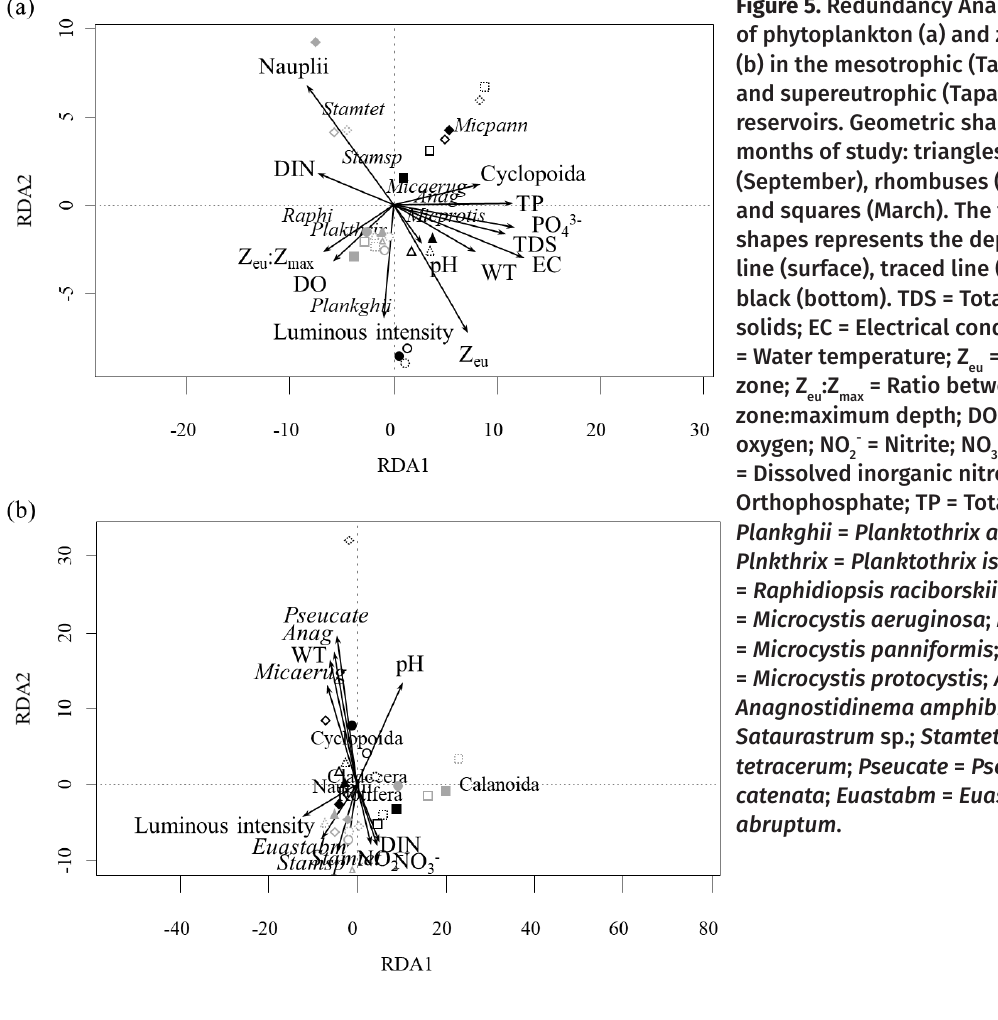
Figure 5. Redundancy Analysis (RDA) of phytoplankton (a) and zooplankton (b) in the mesotrophic (Tabocas, grey) and supereutrophic (Tapacurá, black) reservoirs. Geometric shapes represent months of study: triangles (July), circles (September), rhombuses (January) and squares (March). The filling of the shapes represents the depths: solid ) and all line (surface), traced line (Z eu black (bottom). TDS = Total dissolved solids; EC = Electrical conductivity; WT = Water temperature; Z = Euphotic eu zone; Z :Z = Ratio between euphotic eu max zone:maximum depth; DO = Dissolved oxygen; NO 2- = Nitrite; NO 3- = Nitrate; DIN = Dissolved inorganic nitrogen; PO 43- = Orthophosphate; TP = Total phosphorus; Plankghii = Planktothrix agardhii ; Plnkthrix = Planktothrix isothrix ; Raphi = Raphidiopsis raciborskii ; Micaerug = Microcystis aeruginosa ; Micpann = Microcystis panniformis ; Micprotis = Microcystis protocystis ; Anag = Anagnostidinema amphibium ; Stamsp = Sataurastrum sp.; Stamtet = Staurastrum tetracerum ; Pseucate = Pseudanabaena catenata ; Euastabm = Euastrum abruptum